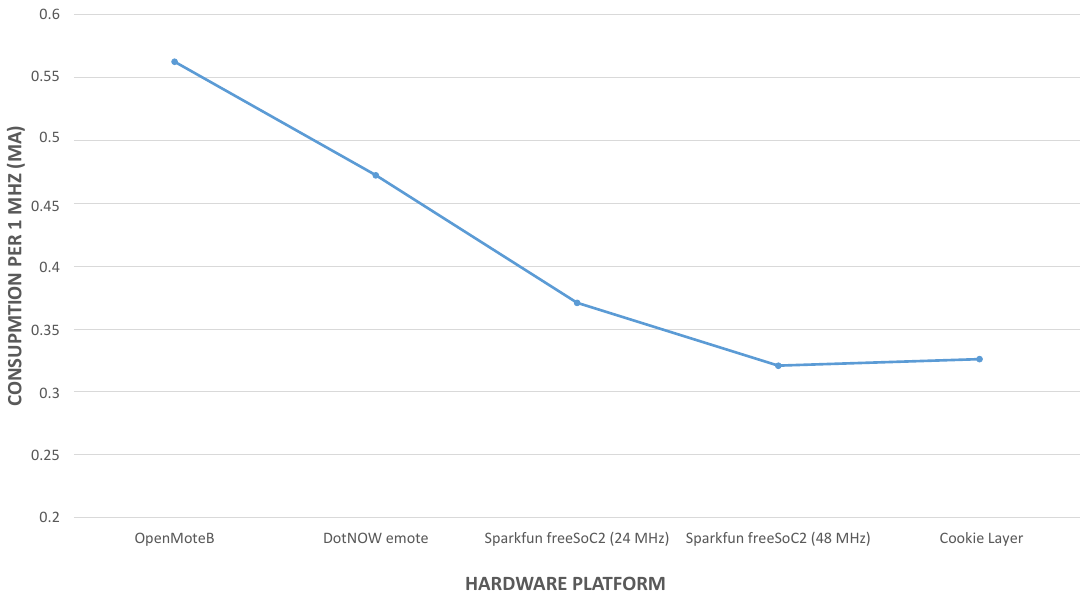
Figure 3. Results comparison of the Extreme Edge nodes considering the current consumption per